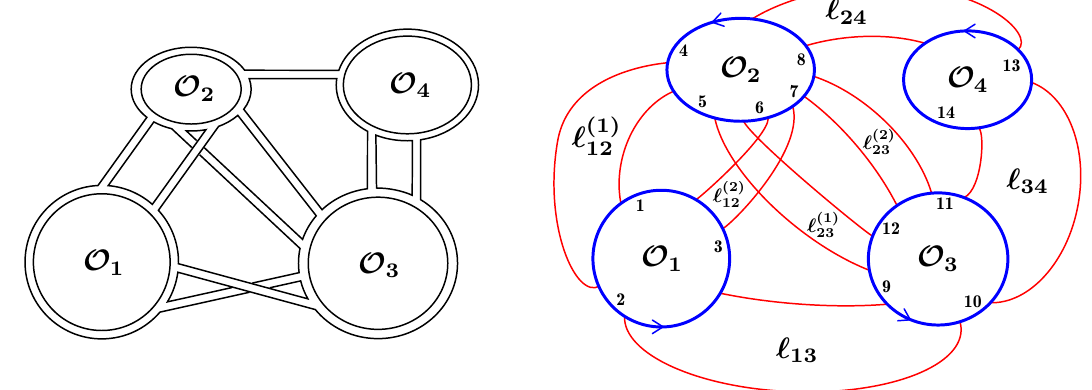
Figure 21 . (Left) Example of a set of the Wick-contractions in hO 1 O 2 O 3 O 4 i with ( L 1 ; L 2 ; L 3 ; L 4 ) = (4 ; 5 ; 6 ; 3). (Right) Skeleton-reduced graph for the same set of Wick- contractions, whose edges are colored as in (cid:12)gure 1. This corresponds to V = (1 ; 4) 1 (2 ; 9) 2 (3 ; 6) 1 (5 ; 12) 1 (7 ; 11) 1 (8 ; 13) 1 (10 ; 14) 2 with (cid:22) L = 7, where the subscript in V repre- sents the bridge length of each open